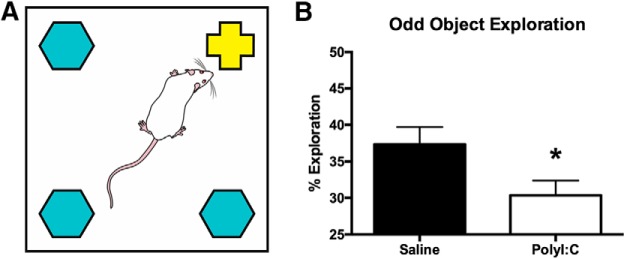
A, Schematic of the white square arena used to conduct the oddity discrimination task showing the arrangement of three identical objects and one different, or odd object. Schematic has been published previously (Lins et al., 2018). B, bar graph displaying the percentage of total object exploration spent examining the odd object. PolyI:C offspring displayed significantly less oddity preference than saline offspring (*p < 0.05).